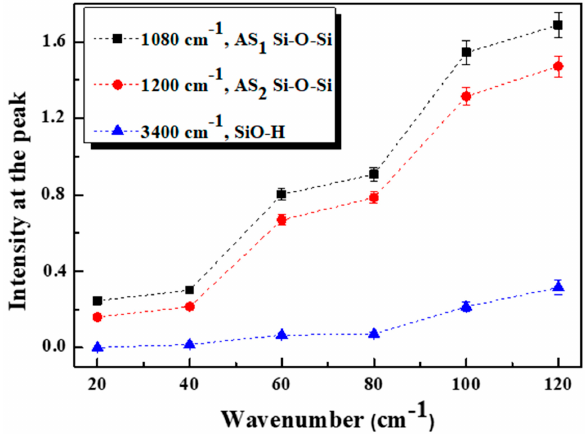
Figure 9. Evolution of peaks intensity of dominant FTIR bands versus etching time.